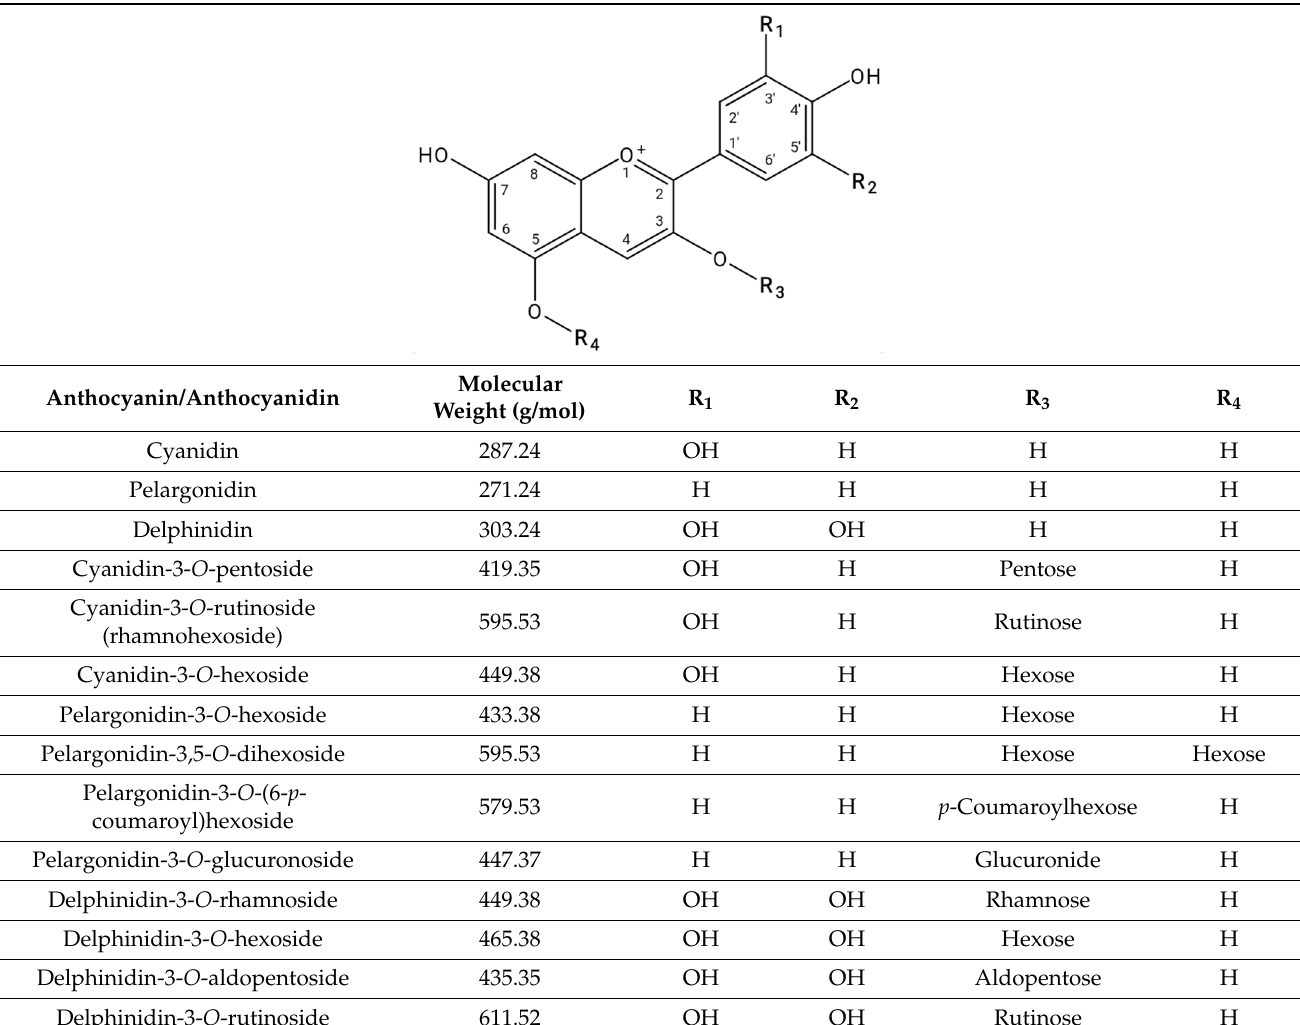
Table 4. Anthocyanidins and their substitutions.